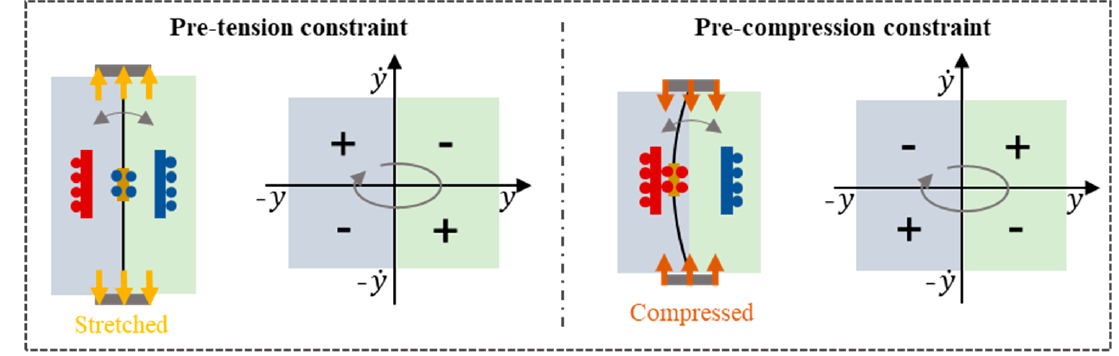
Figure A3. The value of λ when beam is under pre-tension or pre-compression